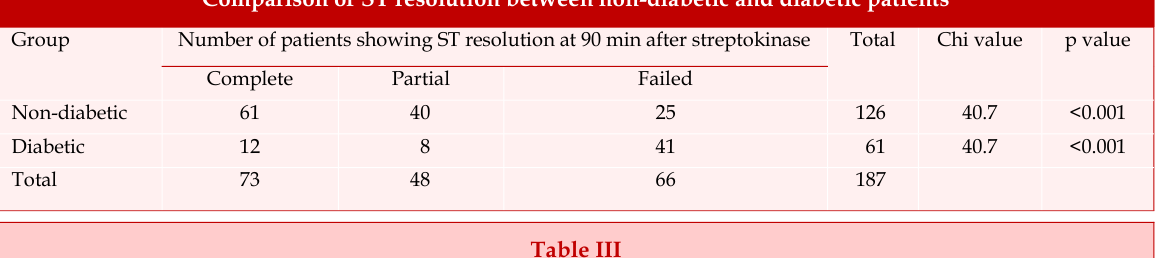
Comparison of ST resolution between non-diabetic and diabetic patients